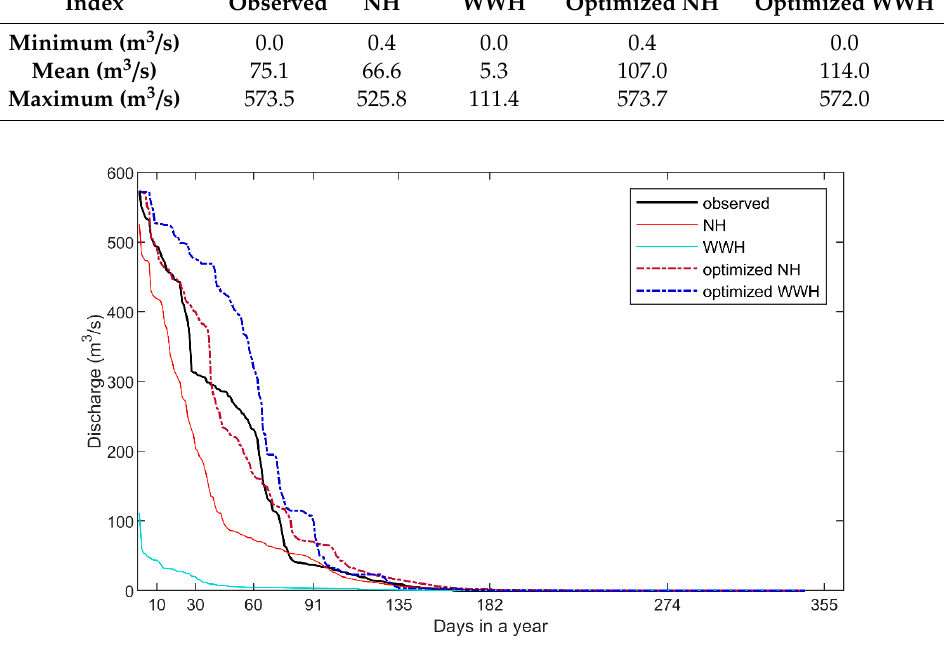
Figure A1. Flow duration curve of the Sirba River at Bossey Bangou in the validation year 2019. Observed flow, NH and WWH (5 day) forecasts before and after the optimization.